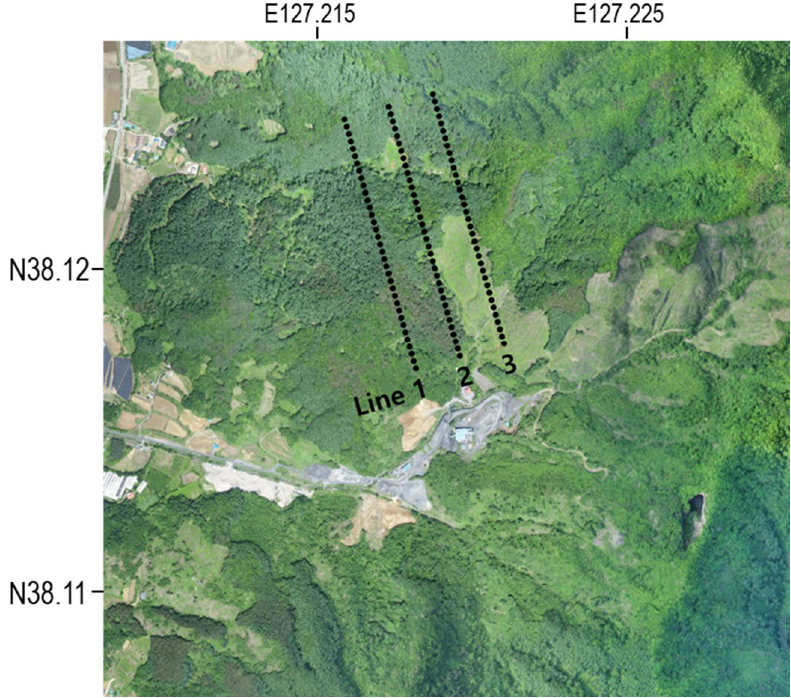
Figure 3. Configuration of electrical resistivity survey with photographic view in the Gonamsan intrusion.